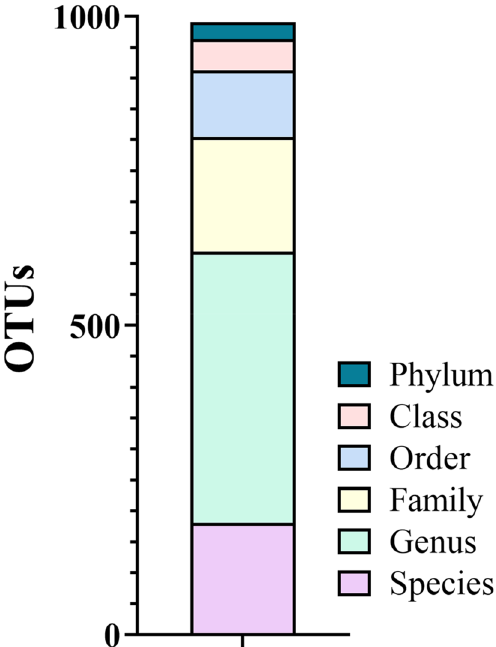
Figure 1. Overview of macropod oral plaque taxonomic profiling in this study. Numbers of OTUs (operational taxonomic units) taxonomically assigned to the phylum, class, order, family, genus, and species levels overall are